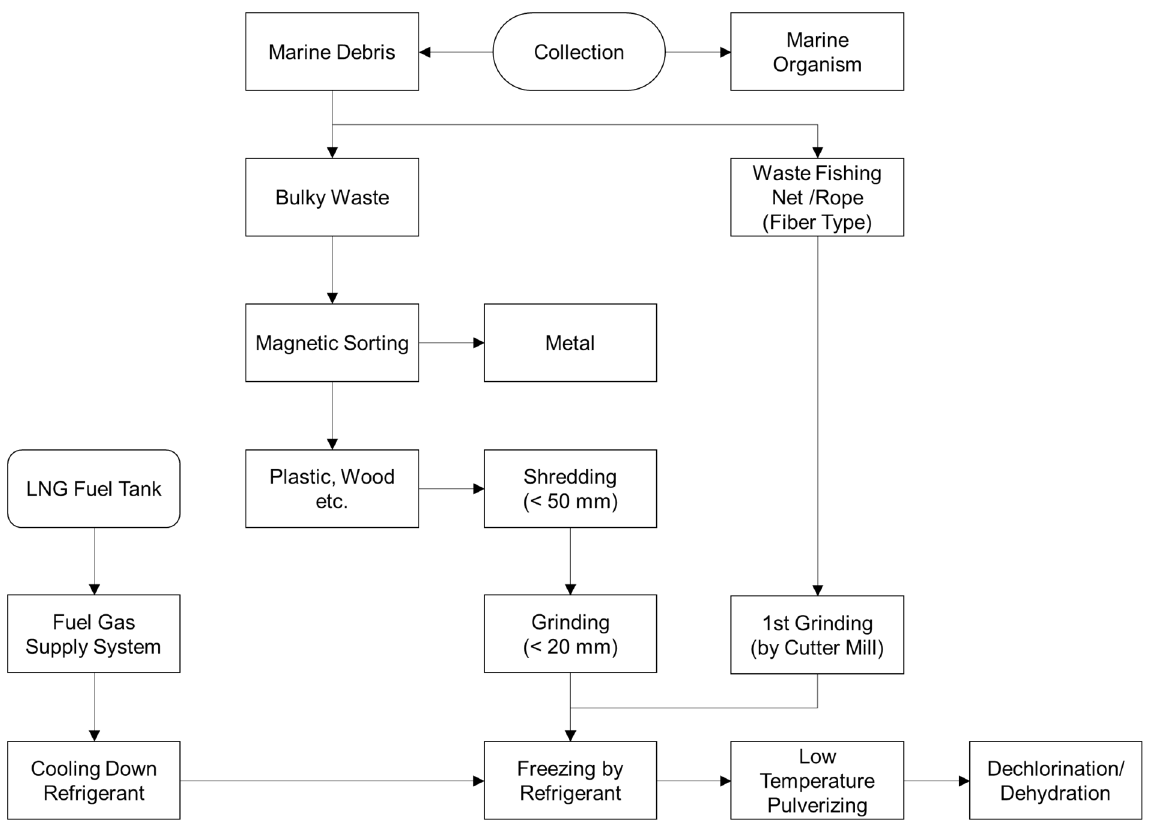
Figure 5. Low-temperature MD pulverizing process utilizing